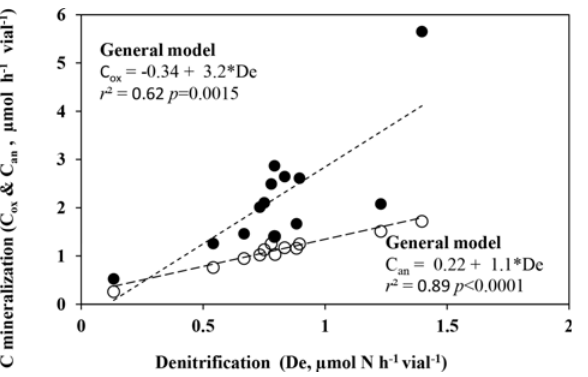
Fig 5. Links between denitrification and C mineralization. Relationship between C mineralization rate during both oxic [closed circles] and anoxic phase [open circles] and denitrification (De; i.e. production rates of NO+N 2 O+N 2 ). Each point represents mean of triplicates. Linear regression function is shown for both oxic (C ox ) and anoxic (C an ) C